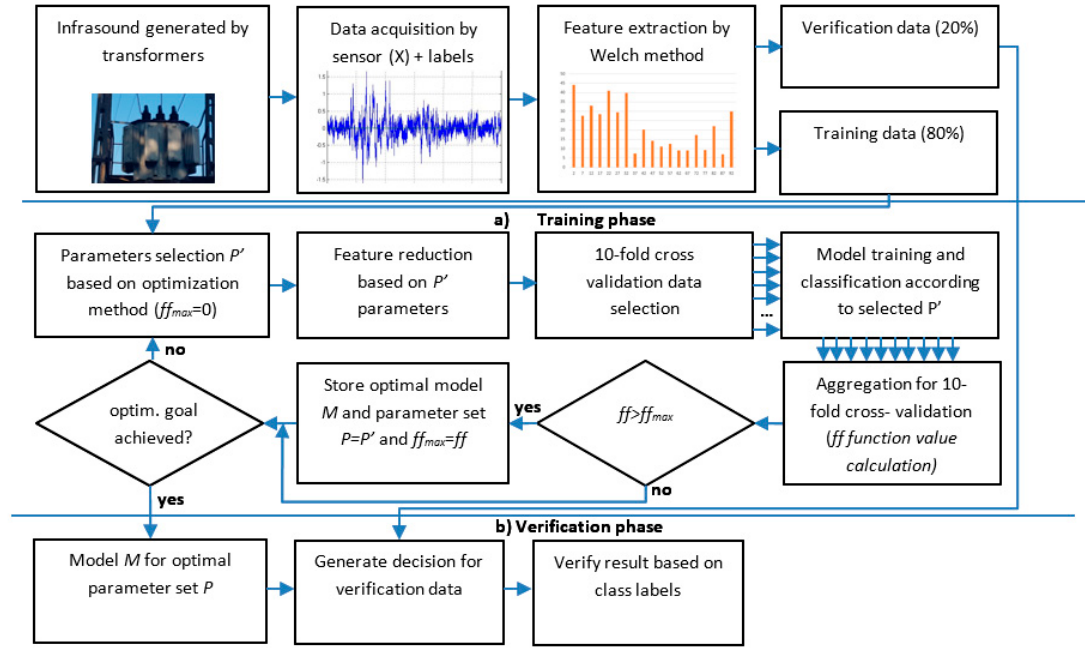
Figure 1. Overview of proposed method.